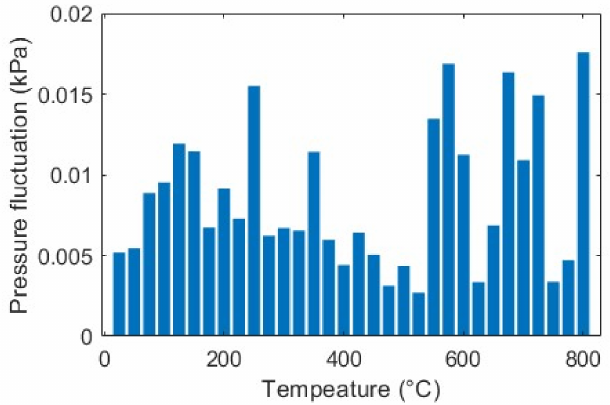
Figure 8. Pressure fluctuation δ P 2 at each measurement.